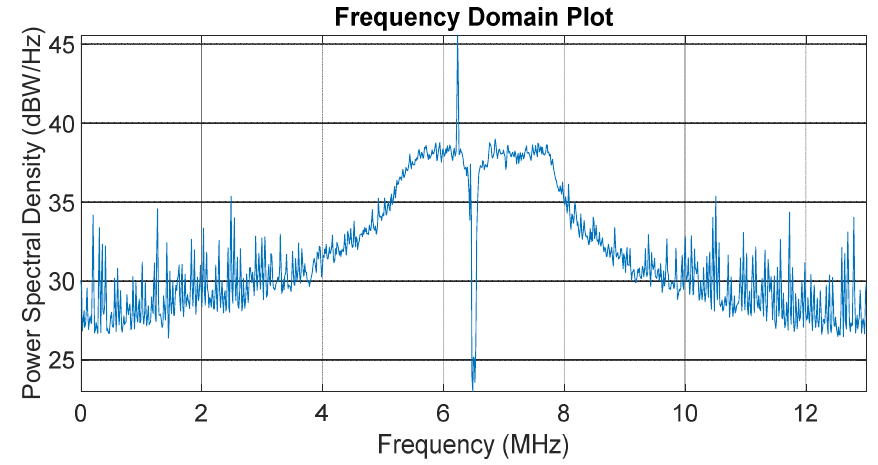
Figure 25. Frequency spectrum of VHDL implementation (float-point with 32-precision) .